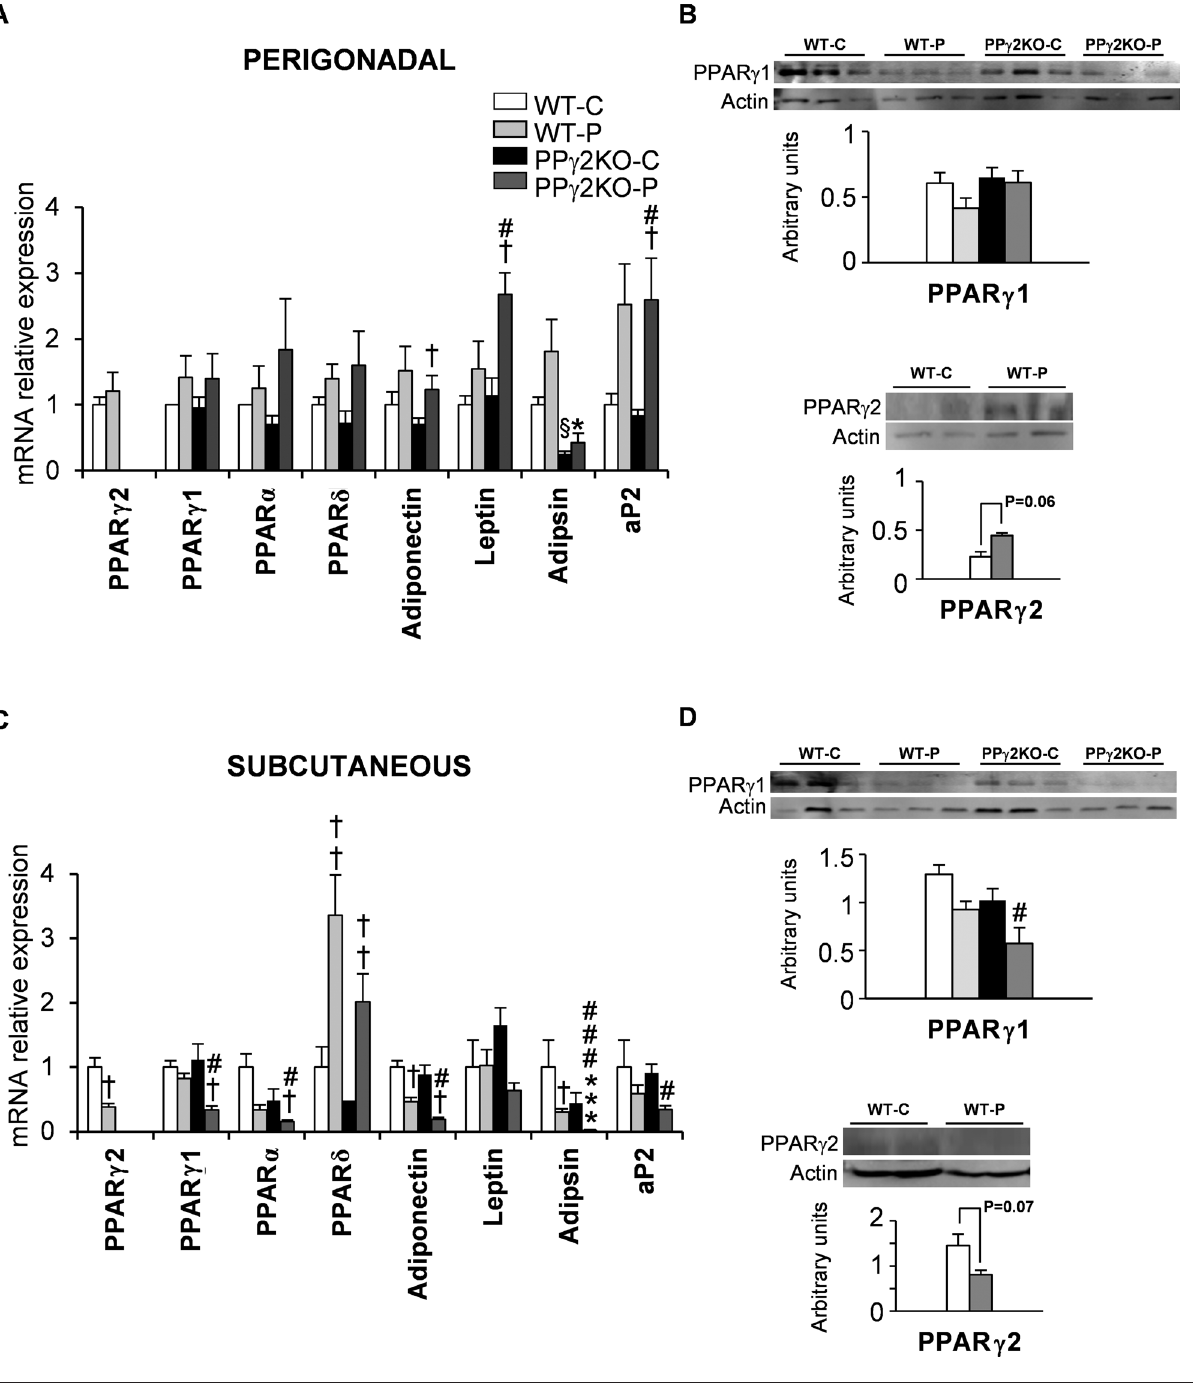
Figure 2. Expression pattern of PPARs and other adipose markers in perigonadal and subcutaneous WAT depots during pregnancy. (A and C) mRNA levels of adipogenic markers and other genes in (A) perigonadal and (C) subcutaneous fat depots from pregnant and nonpregnant WT and PP γ 2KO mice. Data are expressed as mean ± SEM (n = 6–8 animals/group). (B and C) Quantification of PPAR γ 1 and PPAR γ 2 total protein expression in perigonadal (B) and subcutaneous (D) fat depots from pregnant and nonpregnant WT and PP γ 2KO mice. Levels of protein were normalized to total β -actin. Data are expressed as mean ± SEM (n = 3–5 animals/group). * p ≤ .05; *** p ≤ .001 PP γ 2KO-P versus WT-P; # p ≤ .05; ### p ≤ .001 PP γ 2KO-P versus WT-C; † p ≤ .05; ††† p ≤ .001 pregnant versus non pregnant; § p ≤ .05 PP γ 2KO-C versus